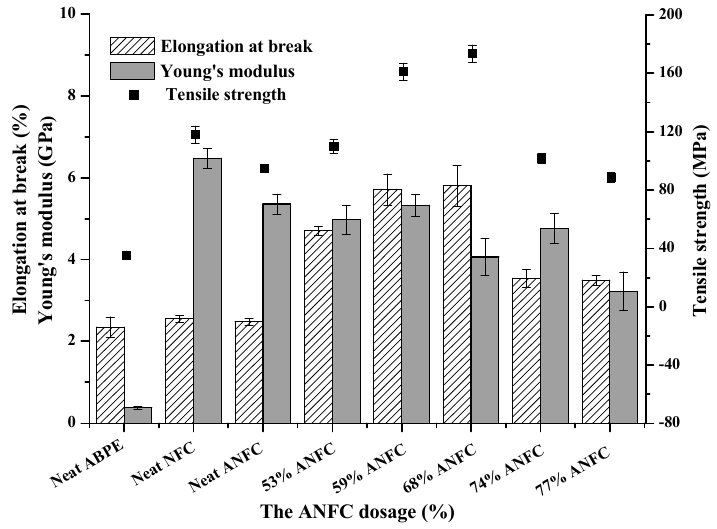
Figure 6. Effects of different ANFC dosages on the mechanical properties of different films.